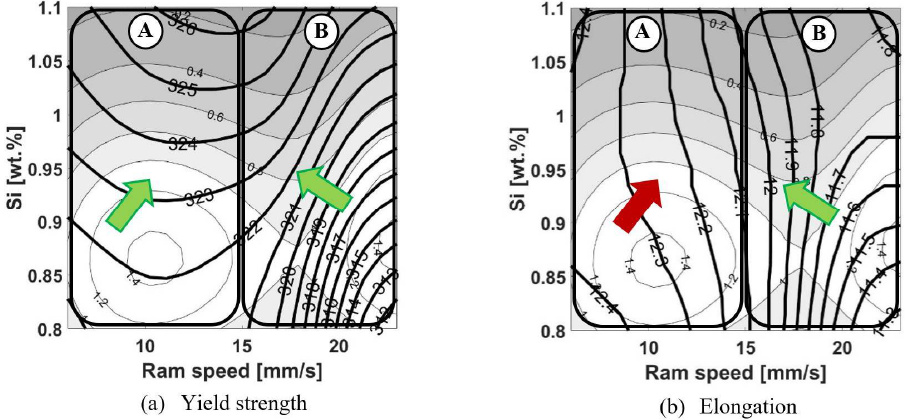
Figure 5. Common influence of ram speed and Si content on yield strength ( a ) and elongation ( b ). Green (grey) and red (dark) arrows indicate increase and decrease of the observed mechanical